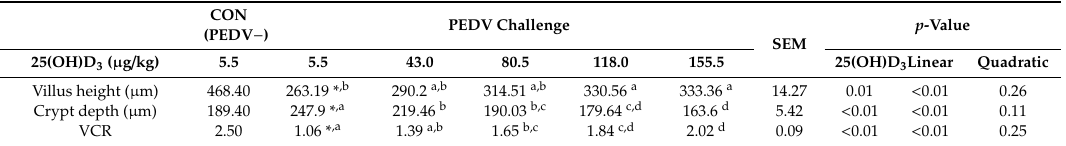
Table 5. Jejunal villous height, crypt depth, and the ratio of villous height / crypt depth (VCR) of weaned piglets fed 25(OH)D 3 as indicated with PEDV challenge.